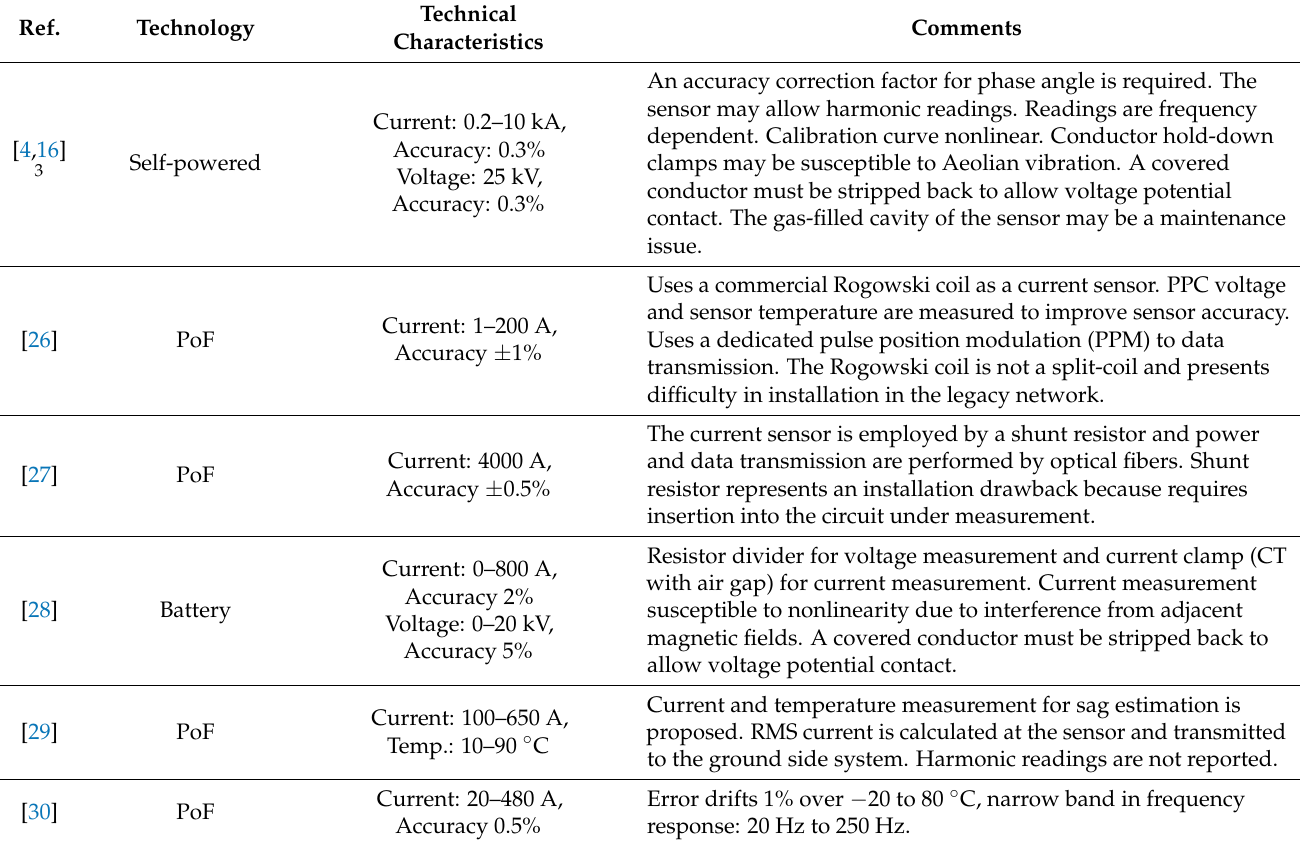
Table 2. Characteristics of hybrid LPIT described in the